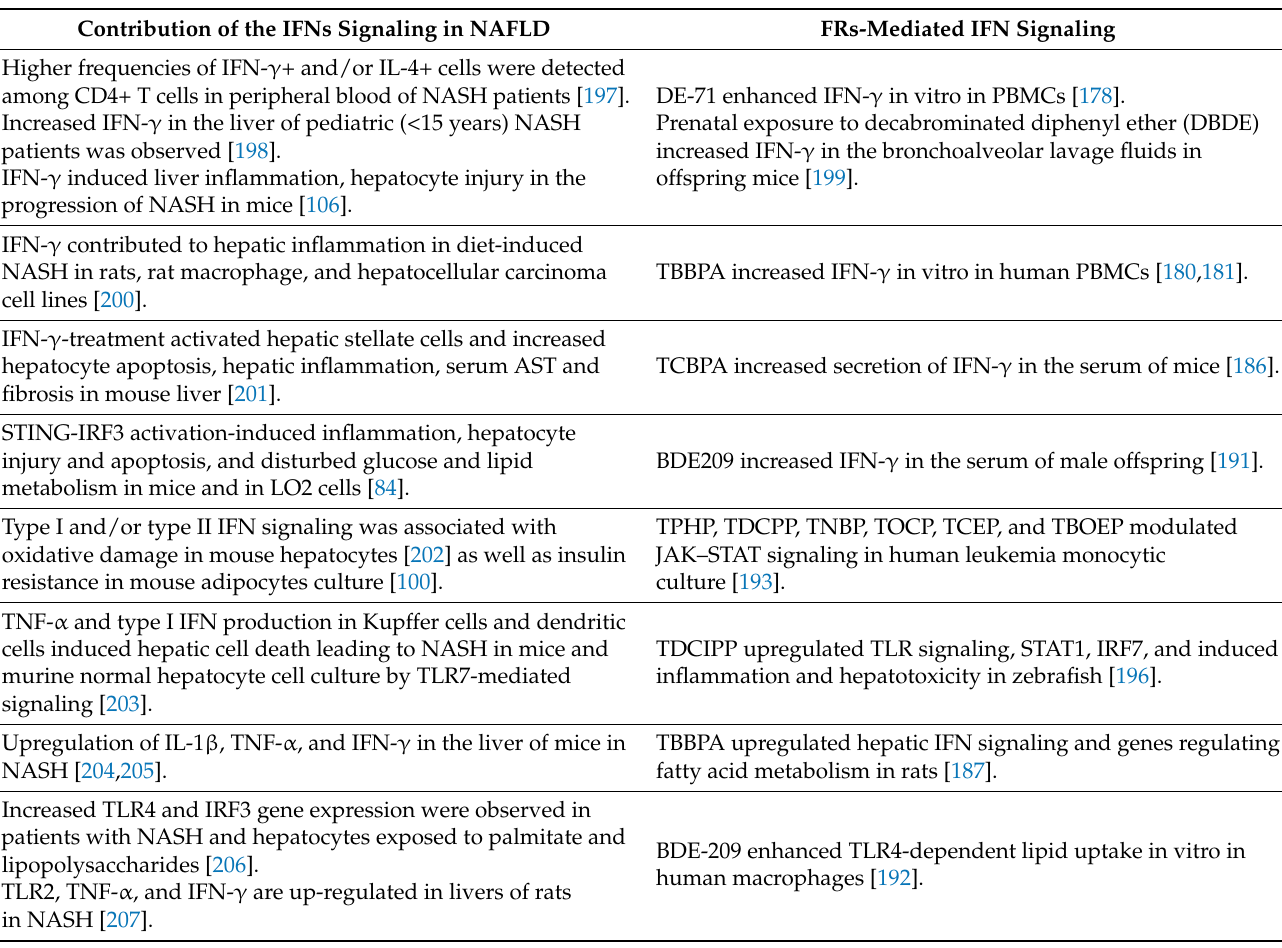
Table 2. A summary of the role of IFN signaling in the development and progression of NAFLD and FRs-mediated IFN signaling, which can potentially impact NFALD